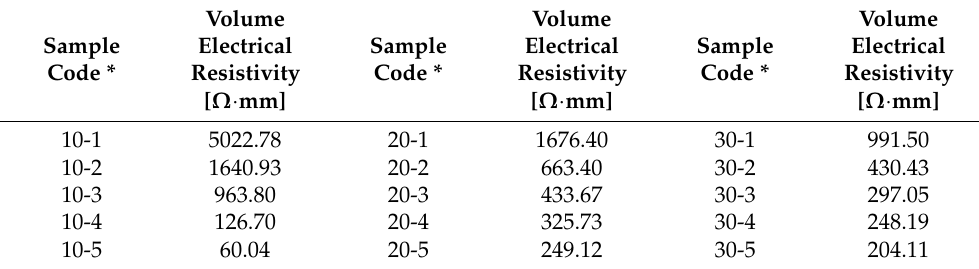
Figure 7. EMI shielding effectiveness (EMSE) of increasing layers for MEFTEX. ( a ) MEFTEX 10 ( b ) MEFTEX 20 ( c ) MEFTEX 30. Table 4. Volume electrical resistivity change and thickness change with increasing of layers.